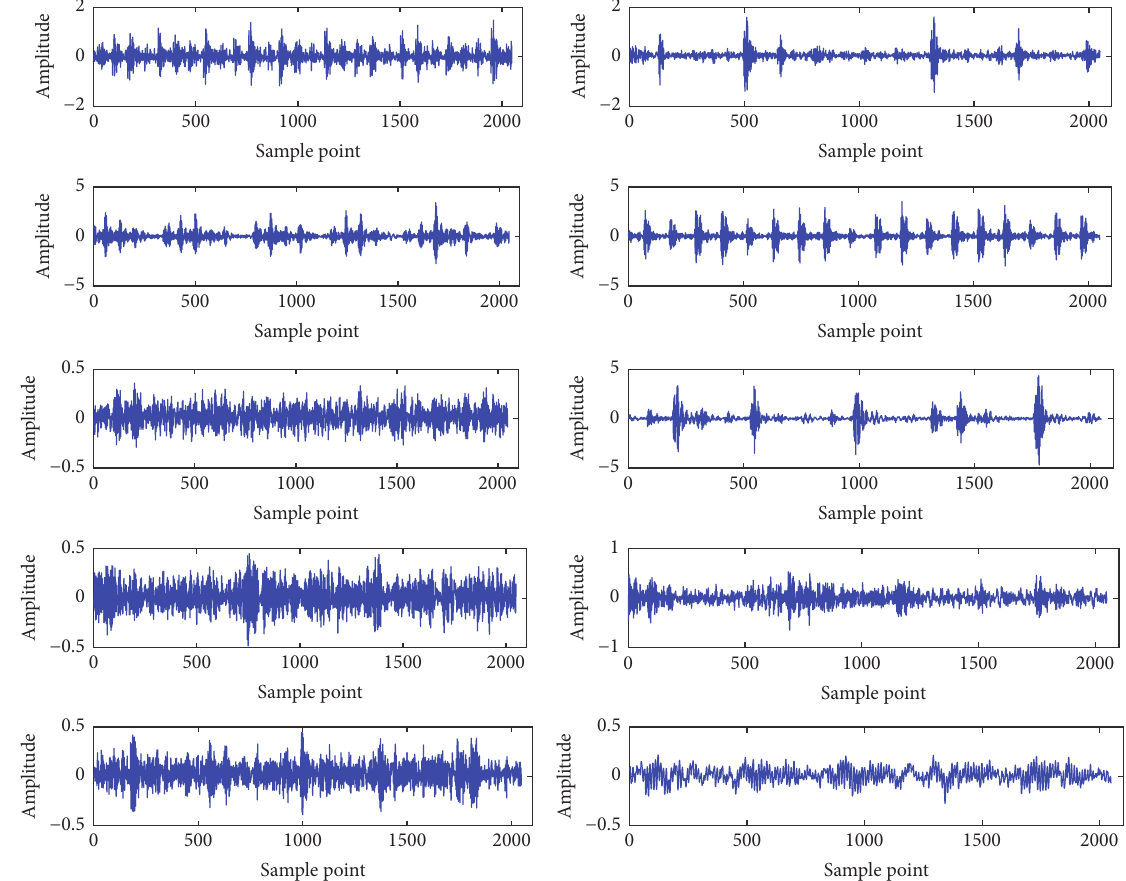
Figure 7: Observation of original signals corresponding to 10 fault